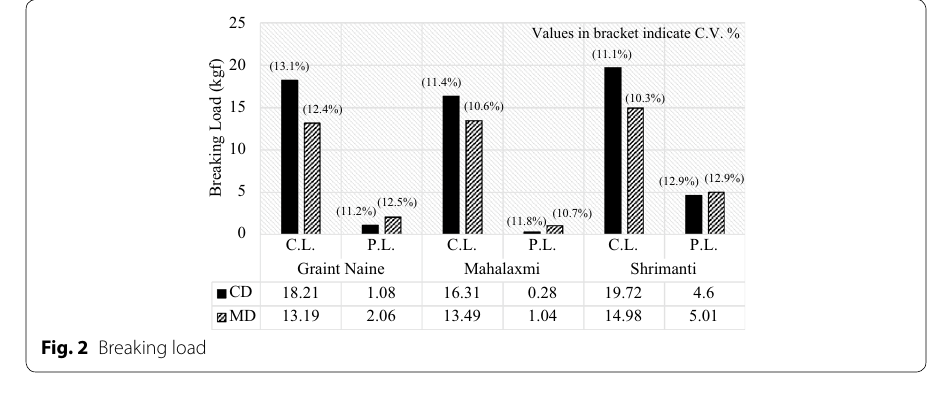
Fig. 2 Breaking load